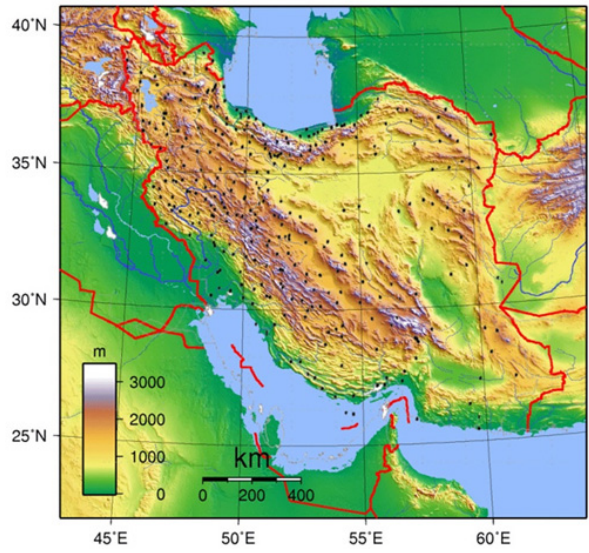
Fig. 1. Topography and Synoptic stations distribution over